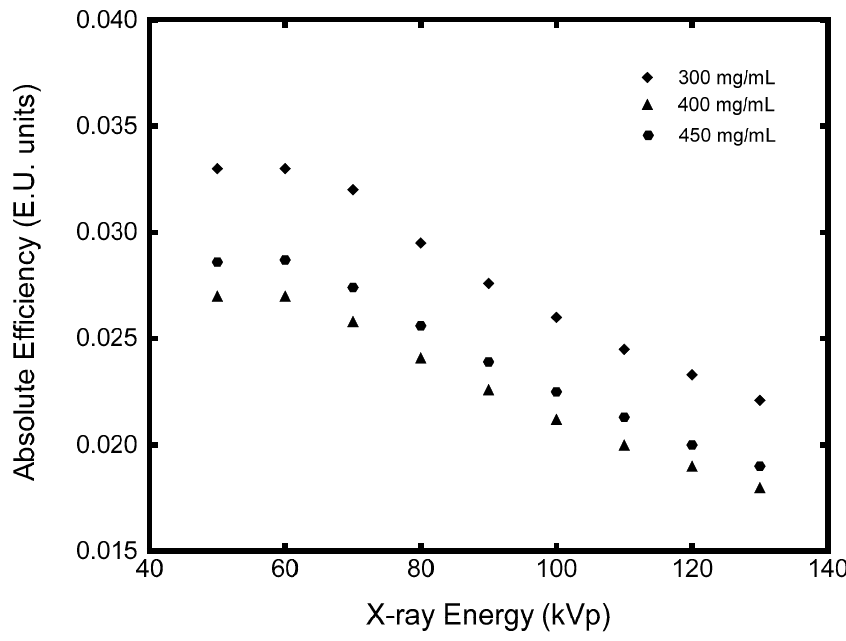
Figure 6. Comparison between predicted AE values for 300 mg / mL, 400 mg / mL, and 450 mg / mL ZnCuInS / ZnS concentrations for X-ray tube voltages used for radiographic applications.